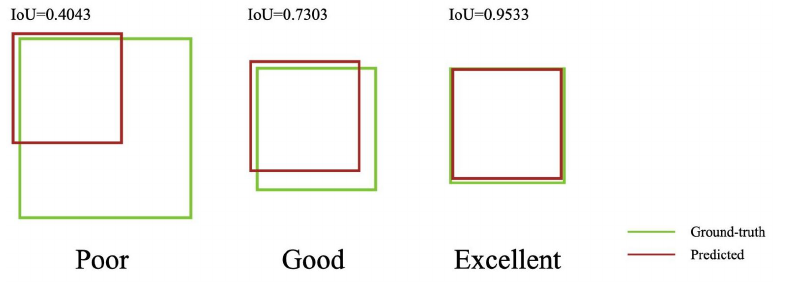
Figure 5. The measurement of intersection over union